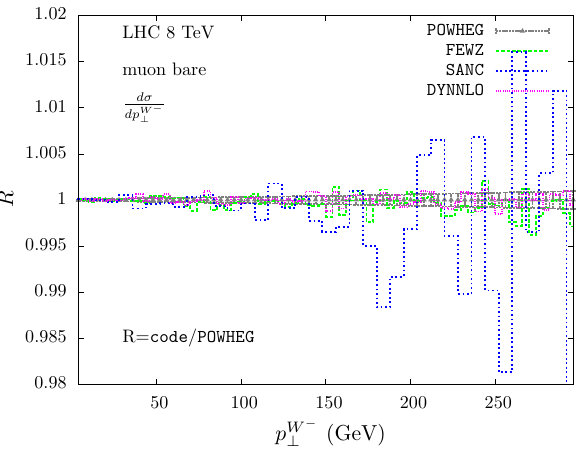
Fig. 10 Tuned comparison of the lepton-pair transverse momentum distributions in pp → W − → μ − ¯ ν μ + X at the 8 TeV LHC with ATLAS/CMS cuts in the bare setup at high p W ⊥ , including NLO QCD